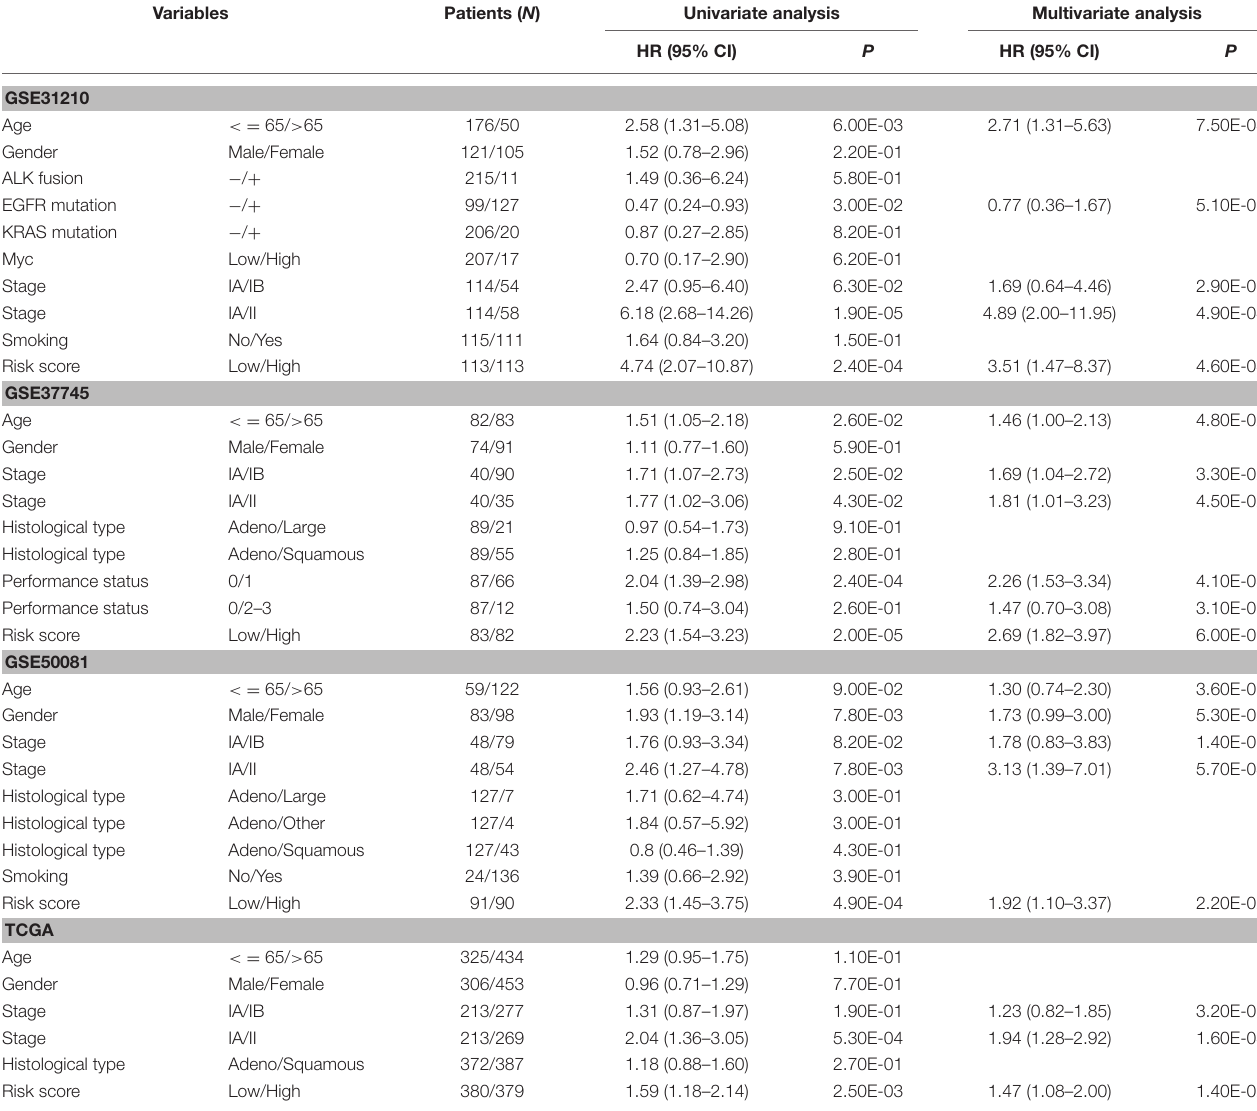
TABLE 3 | Univariate and multivariate Cox regression analyses of the gene signature and overall survival of NSCLC patients in 4 independent datasets. Variables Patients ( N )